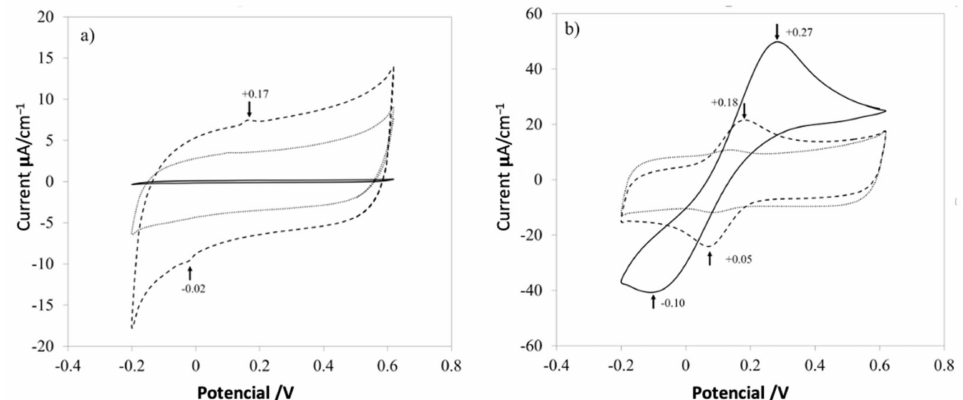
Figure 8. Electrochemical kinetics of PVA nanofibers on a screen-printed electrode. Cyclic voltammo- grams of the screen-printed electrode (solid line), pure PVA (dotted line), and PVA + CNx (dashed line), showing their electrochemical response to an aqueous solution of 1 M KCl ( a ) and Fe (CN) 6 − 3 /Fe (CN) 6 − 4 ( b